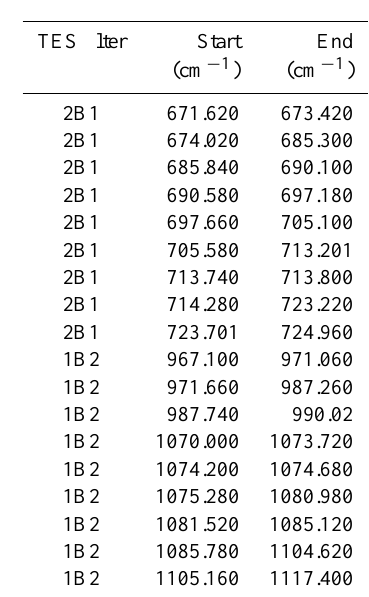
Table 1. Spectral windows used for TES CO 2